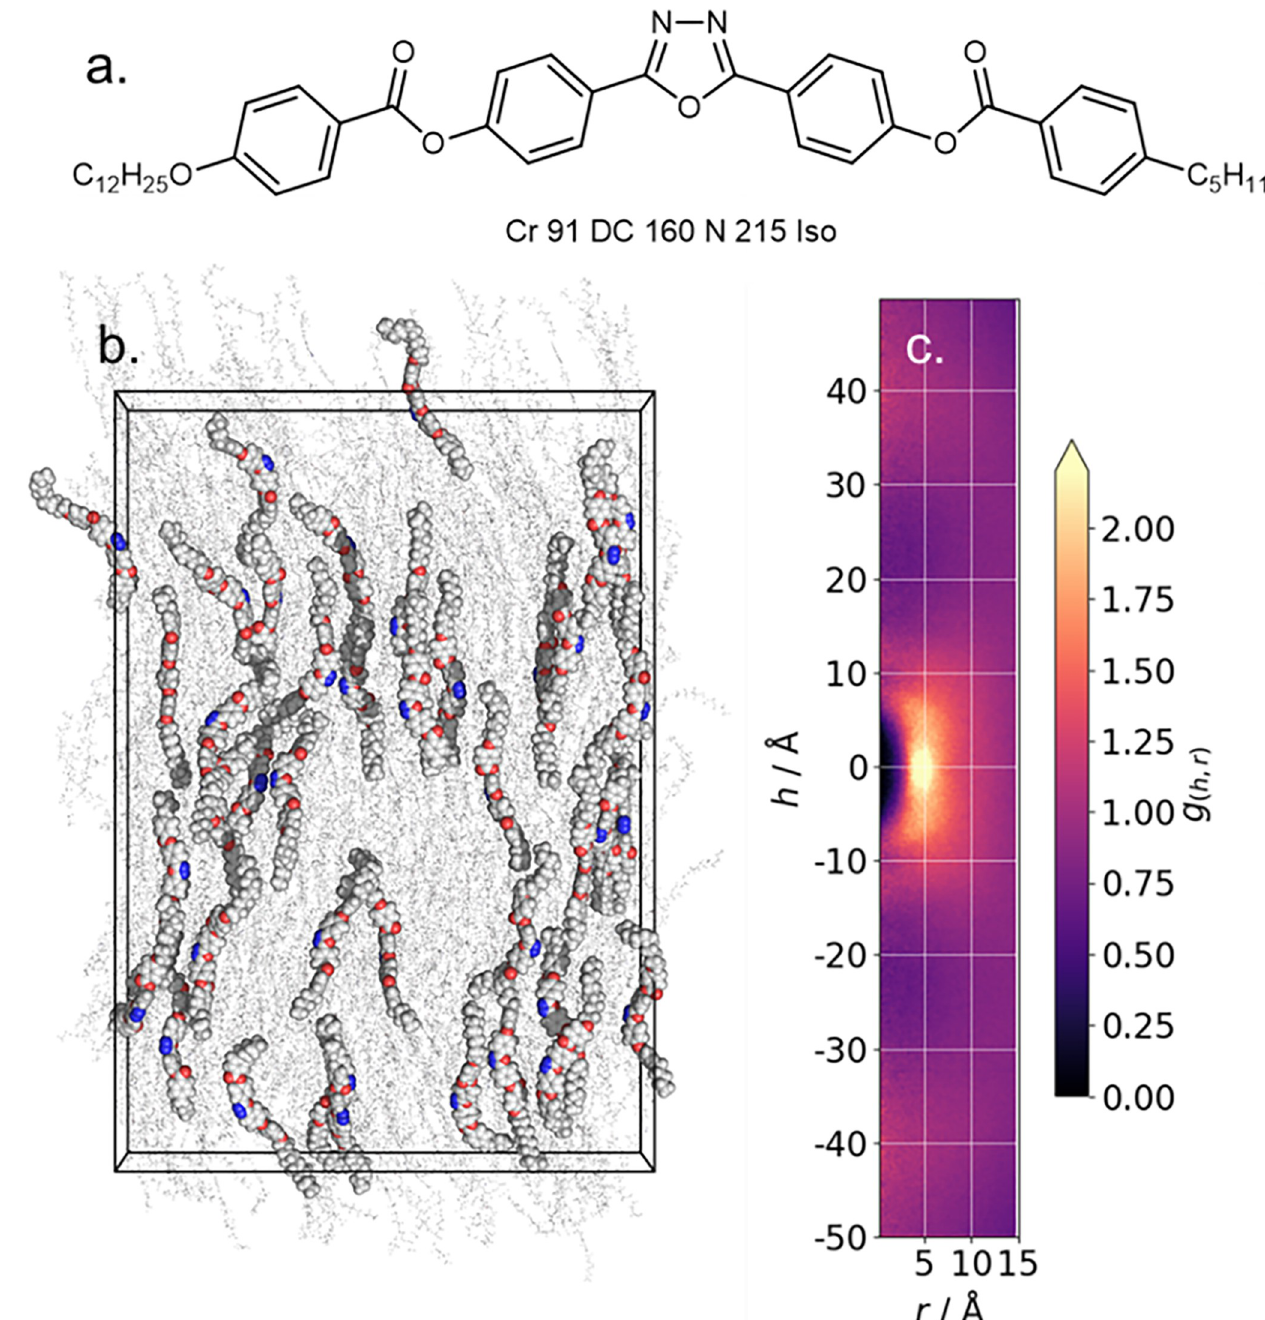
Fig 4. (a) Molecular structure and transition temperatures (˚C) of C5-Ph-ODBP-Ph-OC12 [42]; (b) Instantaneous configuration of the nematic phase of the same material (T = 463 K, t = 236 ns), (c) CDF plot produced over the entire production trajectory; the cylinder length cut-off was extended to 50 Å using the– L 50